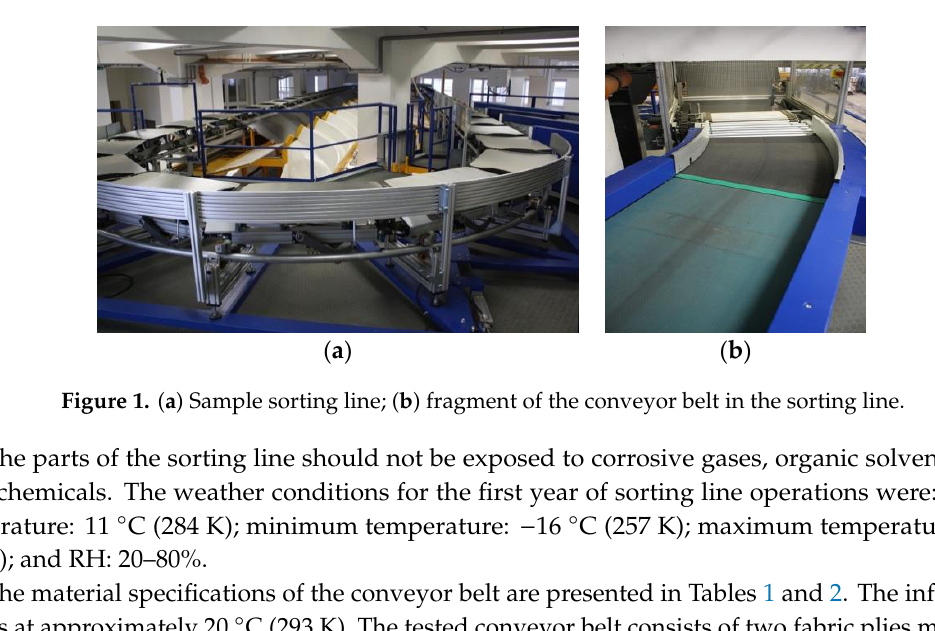
Table 1. The characteristics of the conveyor belt (based on [20]).